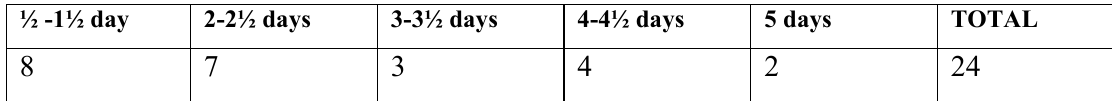
Table 1: Length (in days) of citizens’ juries convened in Australia 1976-2006 (as at April